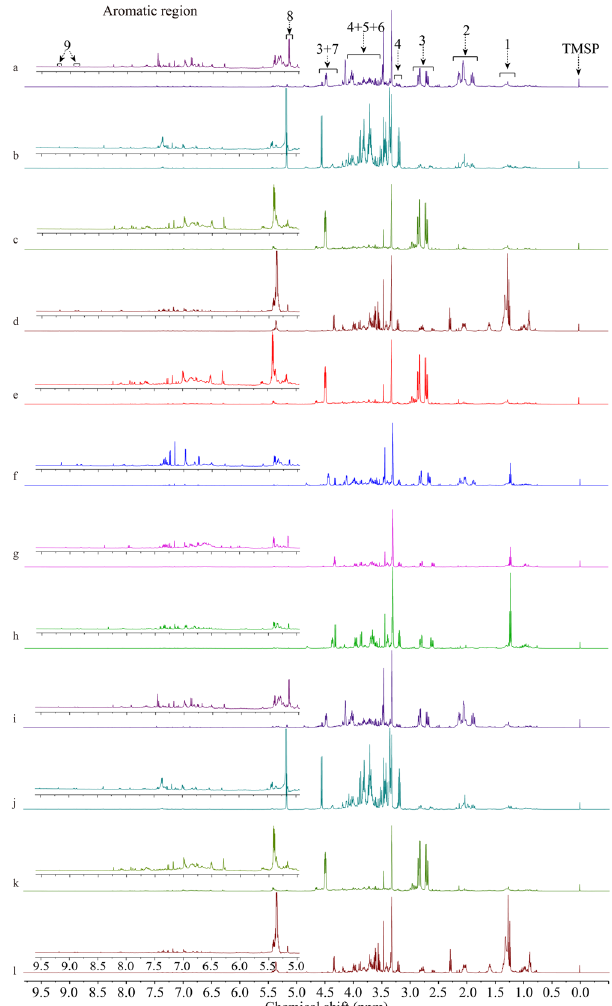
Figure 1. Representative 1 H NMR spectra of berry sample extracts from seven species and seven subspecies of Hippophaë (0.0~9.5 ppm). (1) fatty acids, (2) quinic acid, (3) malic acid, (4) glucose, (5) L-quebrachitol, (6) D-fructose, (7) β -D-glucose, (8) α -D-glucose, (9) trigonelline, ( a ) H . rhamnoides ssp. sinensis , ( b ) H . rhamnoides ssp. mongolica , ( c ) H . rhamnoides ssp. yunnanensis , ( d ) H . rhamnoides ssp. turkestanica , ( e ) H . rhamnoides ssp. wolongensis , ( f ) H . goniocarpa , ( g ) H . litangensis , ( h ) H . neurocarpa ssp. neurocarpa , ( i ) H . neurocarpa ssp. stellatopilosa , ( j ) H . salicifolia , ( k ) H . gyantsensis , and ( l ) H . tibetana